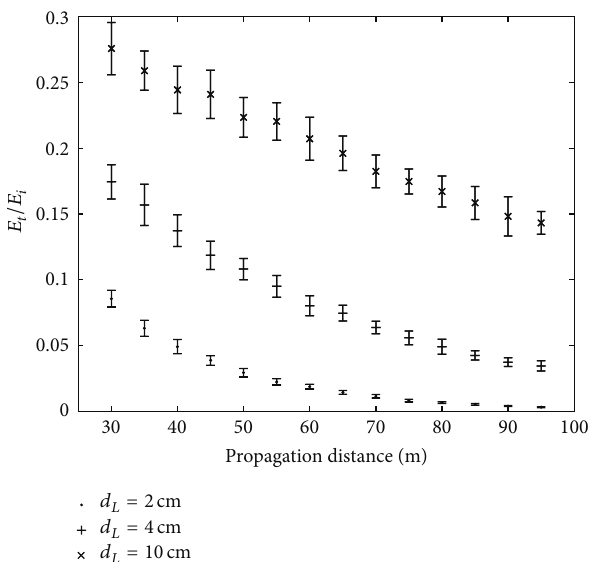
Figure 4: Mean and standard deviation for transmission when different propagation distances and layers thickness are considered (details are given in text).